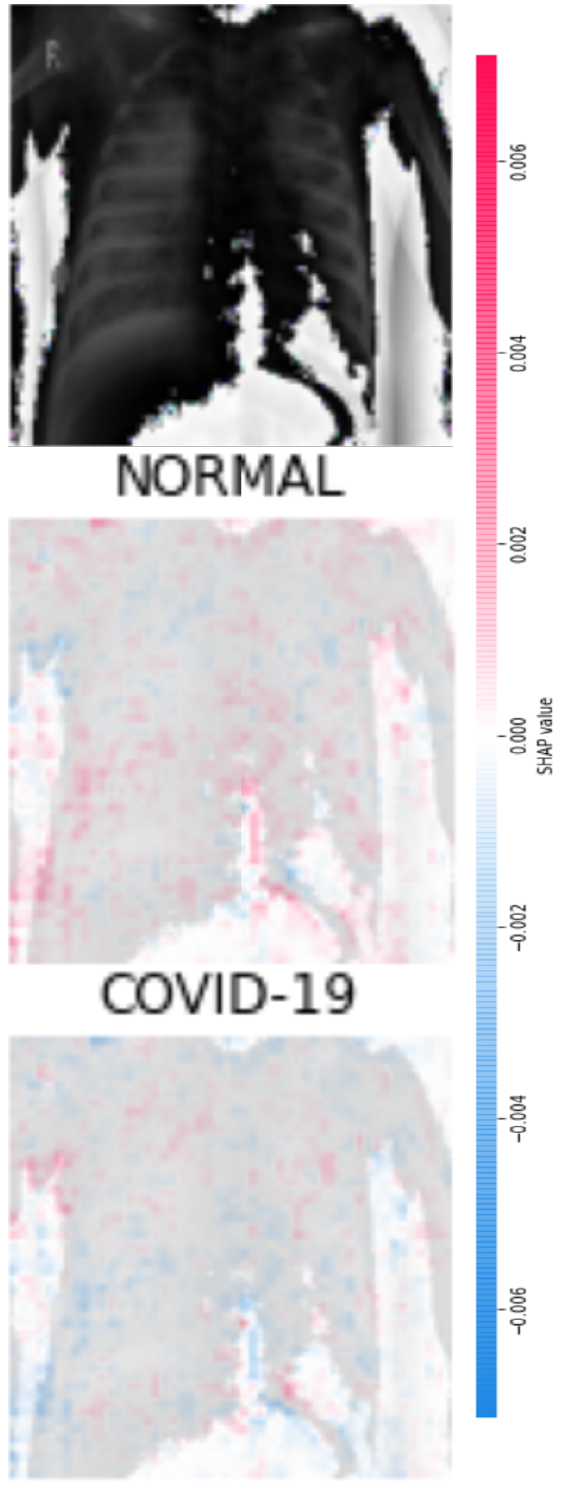
Figure 12. SHAP scores for the image displayed in Figure 9